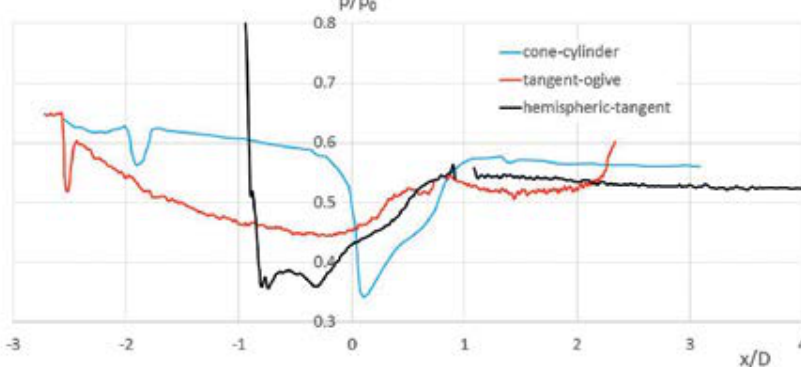
Figure 17. Comparison of pressure ratio for all three cases. Mach number of 0.95 for cone–cylinder, and 0.99 for tangent–ogive and